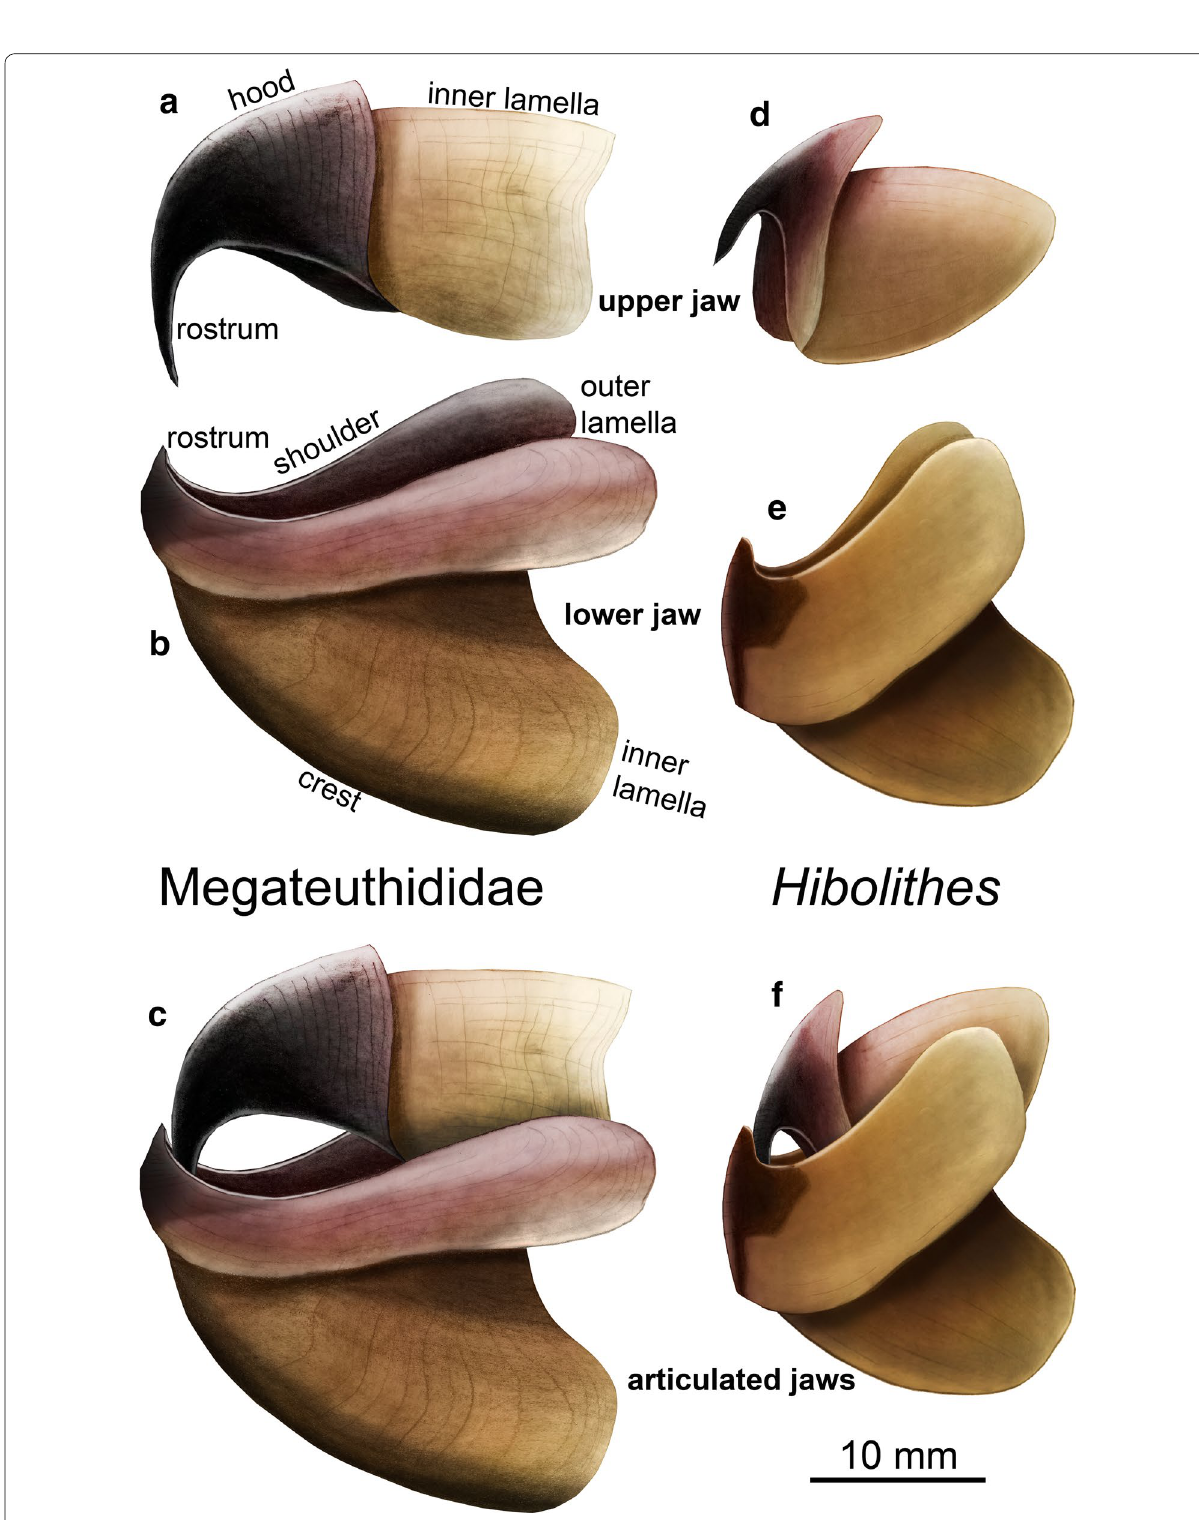
Fig. 5 Reconstructions of Jurassic belemnite jaws. a–c Acrocoelites conoideus from the Swiss Aalenian. d–f Hibolithes semisulcatus from the German Kimmeridgian, modified after Klug et al. (2010b); the inner lamella of the lower jaw was